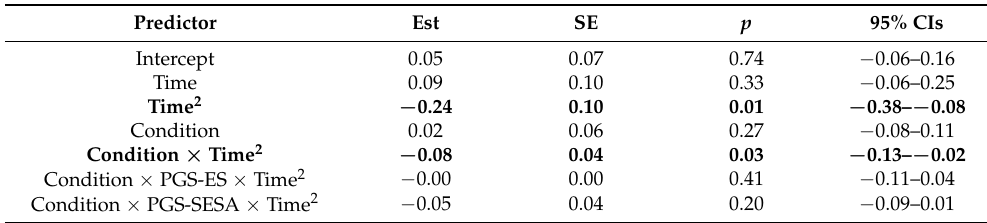
Table 3. Multilevel model statistics testing the intervention effect and moderator effect on conduct problems.